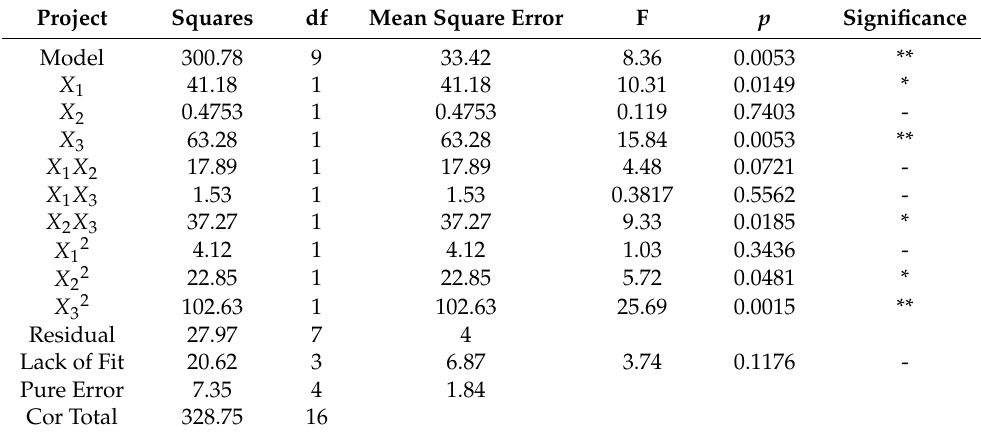
Table 6. Regression model analysis of variance for soil fertilizer mixing